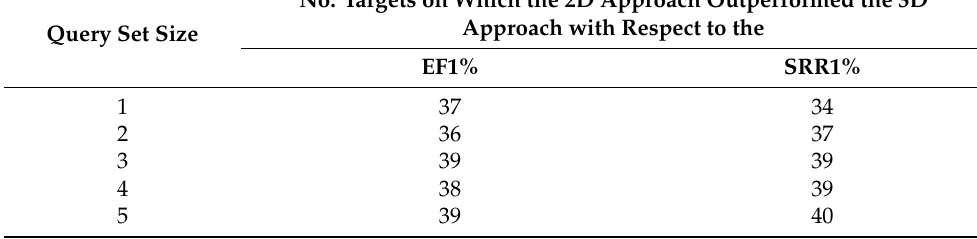
Table 3. Number of Targets on which the 2D Method Outperformed the 3D Method. Query Set Query Set Size